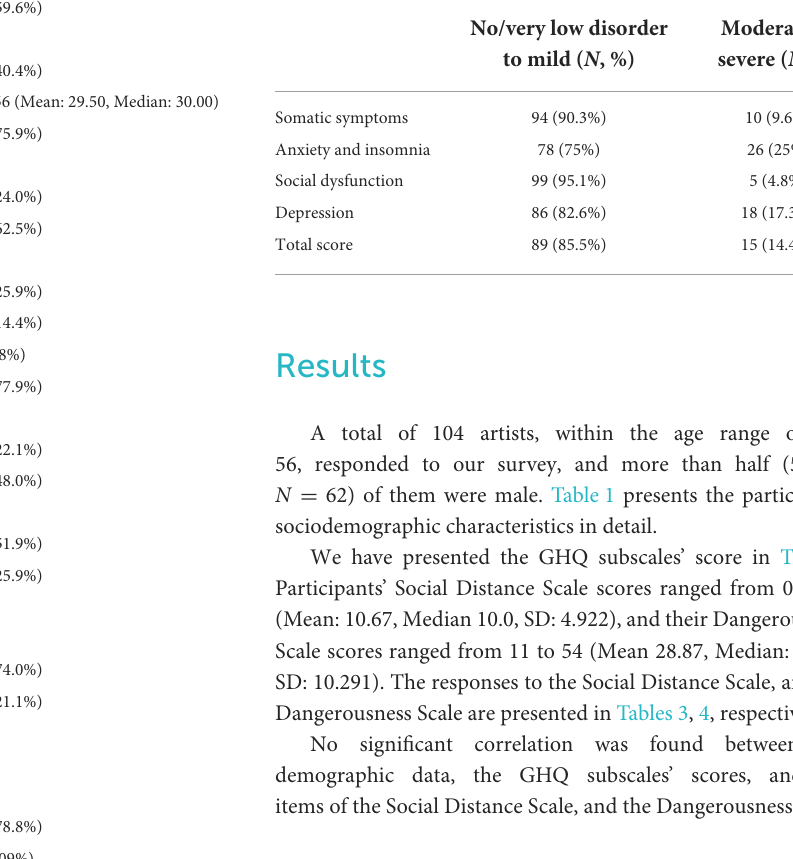
TABLE 2 Subscales’ scores and total scores of the 28-item General Health Questionnaire